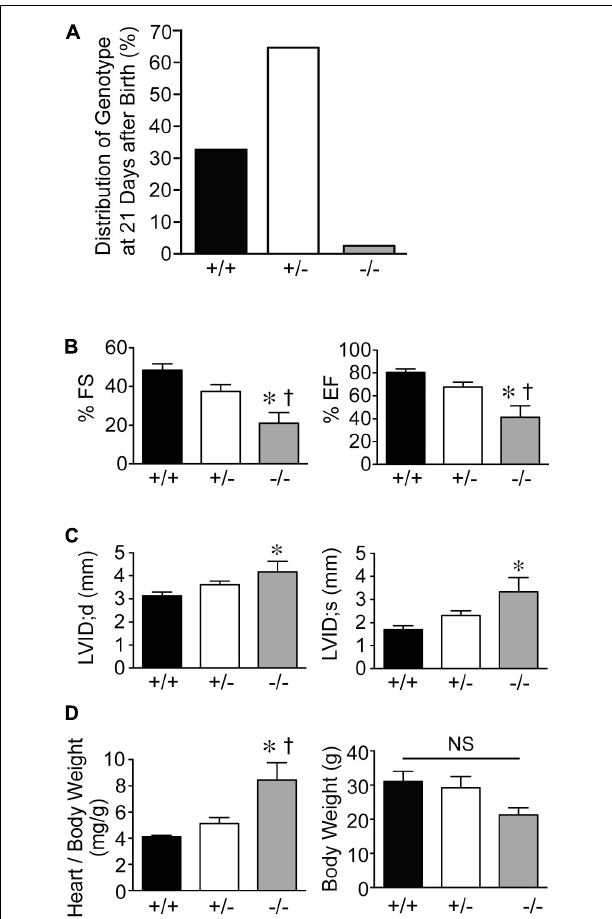
FIGURE 1 | Dilated cardiomyopathy in adult Speg null mice. (A) Genotypes (%) of offspring from breeding of Speg heterologous mice on a C57BL/6 × 129Sv background. Speg wild type (+/+, black bar), heterologous (+/–, white bar), and null (–/–, gray bar) mice at the age of 21 days. Assessment of 305 total pups. (B,C) Echocardiography was performed on the surviving mice at 10–12 weeks of age (+/+, n = 5; +/–, n = 6; –/–, n = 6). (B) Left ventricular fractional shortening (FS, %) and ejection fraction (EF, %). (C) Left ventricular internal diameter (LVID, mm) in diastole and systole. Following echocardiography, mice were sacrificed, and heart and body weight were measured. (D) Ratio of heart to body weight (mg/g, left panel) and total body weight (g, right panel). Analysis performed by one-way ANOVA ( P < 0.05), with significant comparisons ∗ versus +/+; † versus +/–. NS, not significant.